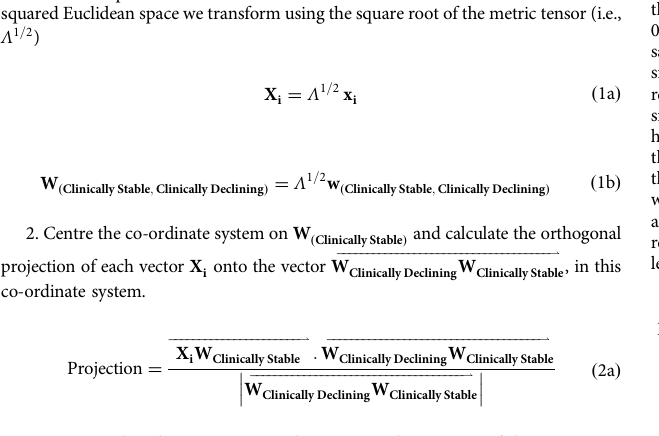
projection of each vector X i onto the vector W ClinicallyDeclining W ClinicallyStable co-ordinate